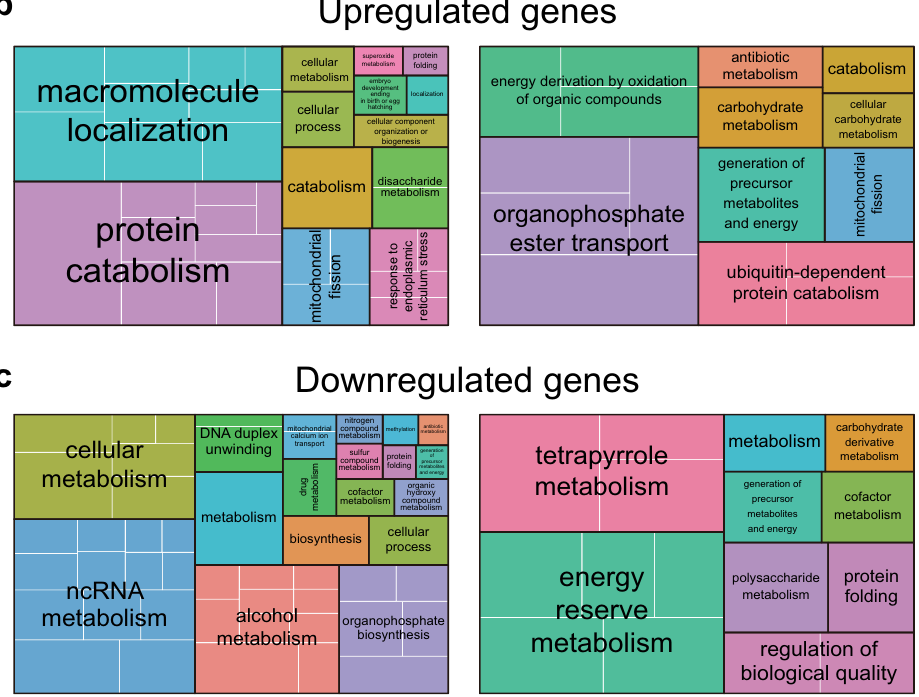
Figure 5. GO enrichment analysis of Pv11 genes potentially regulated by NFAT and CREB following trehalose treatment. ( a ) Heat maps of DEGs that respond to 12-h trehalose treatment, whose promoters contain NFAT or CREB consensus sequences. The heat maps show Z-scored TPM values. ( b , c ) Treemaps of GO enrichment analysis of upregulated and downregulated DEGs ( b and c , respectively). NFAT- and CREB-related GO enrichment is shown on the left and right,